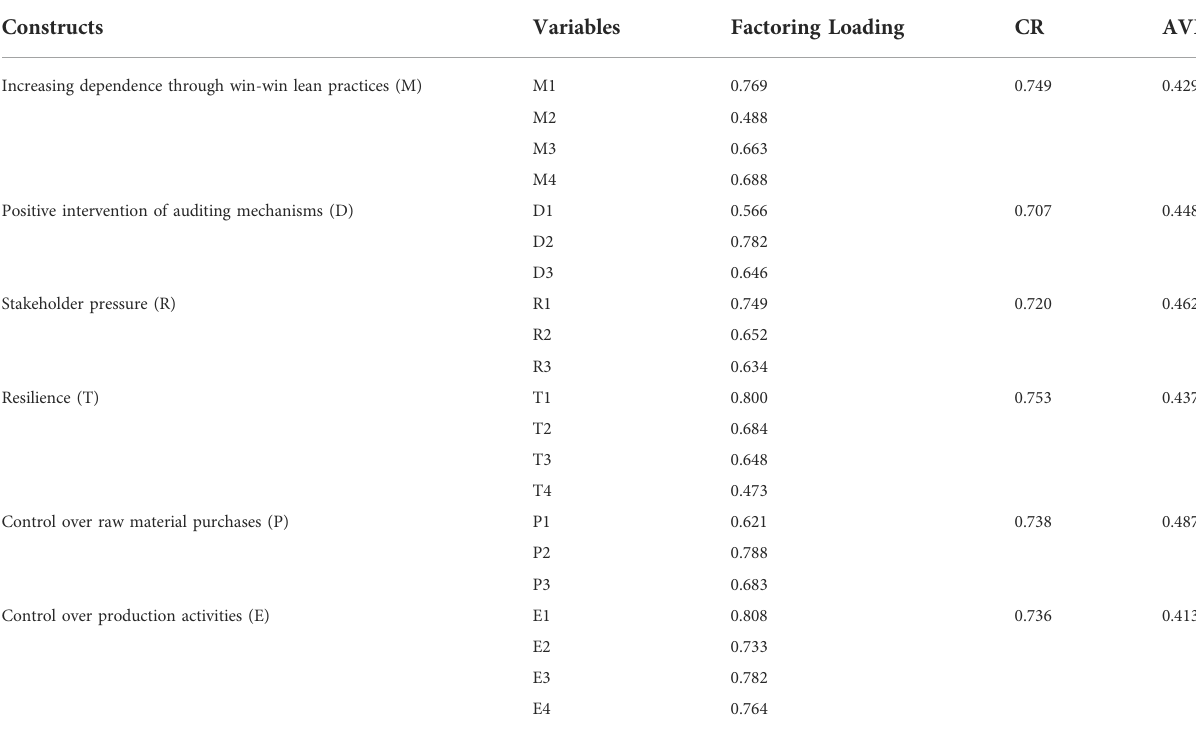
TABLE 3 Analysis results of factor loading, CR, and AVE.